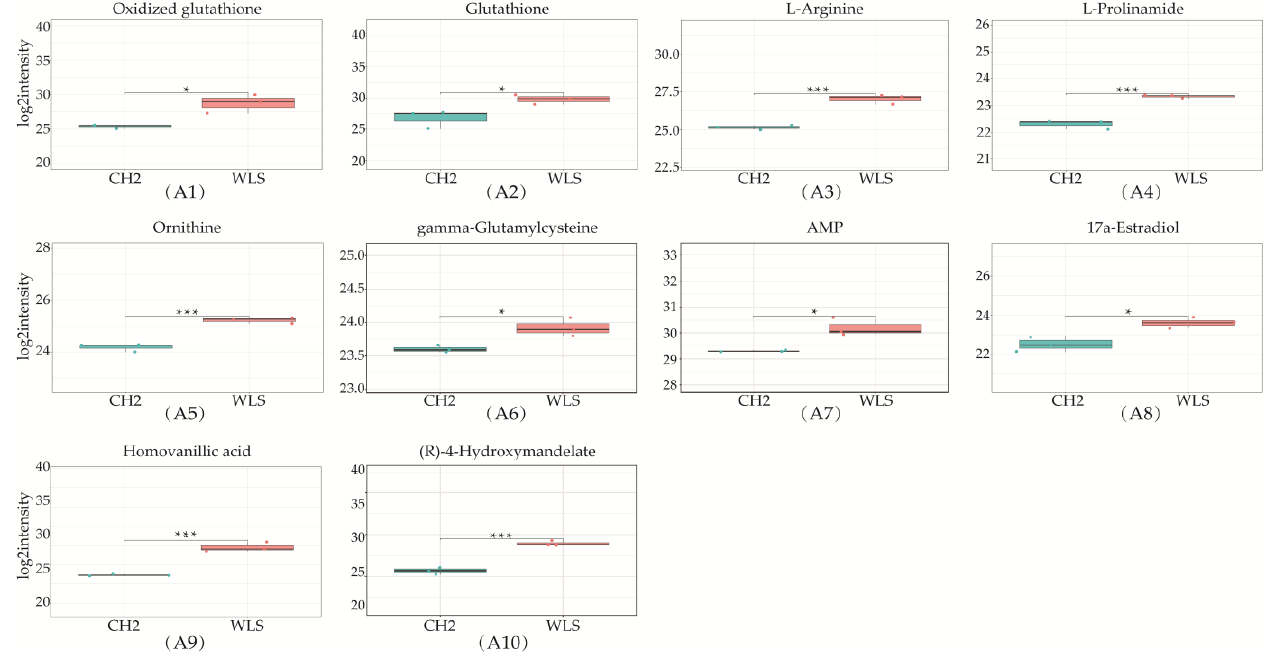
Figure 4. Volcano plot showing the distribution of differential metabolites. Blue represents dow − regulated differential metabolites. Gray represents metabolites that did not meet the filtering parameters. At the top, the names of the five metabolites with the smallest p values are displayed.